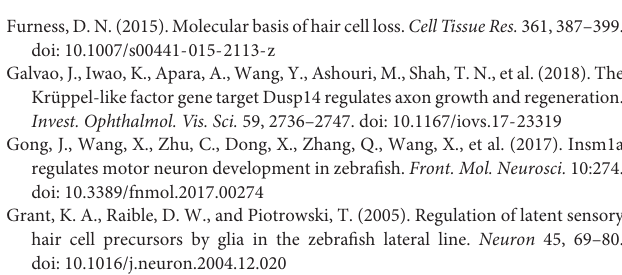
Supplementary Table 2 | Differentially expressed genes obtained based on transcriptome sequencing. Supplementary Table 3 | Primer